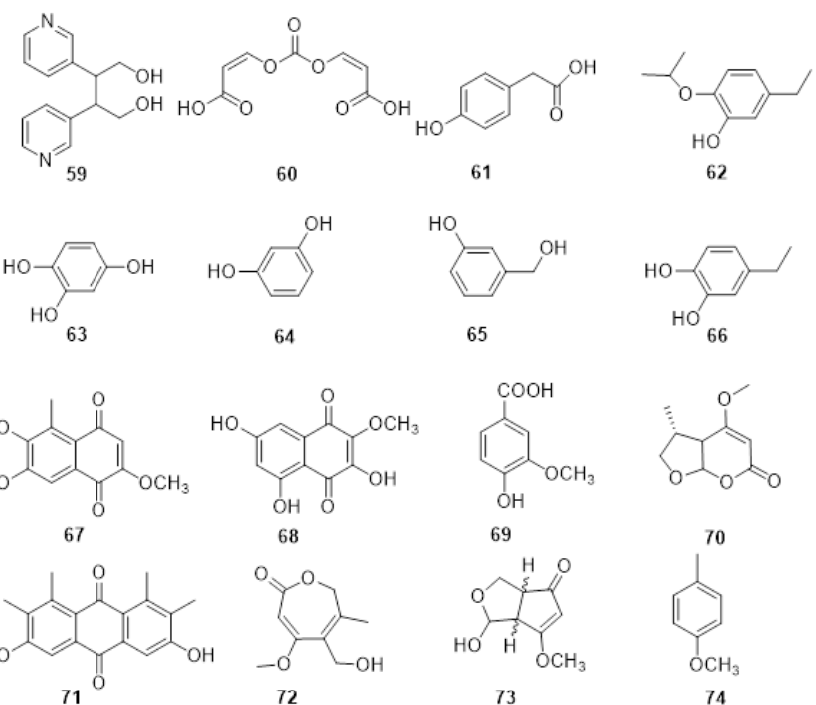
Figure 6. Structure of spencertoxin ( 59 ), spencer acid ( 60 ), 2-(4-hydroxyphenyl) acetic acid ( 61 ), 5-hydroxymethyl-2-isopropoxyphenol ( 62 ), benzene-1,2,4-triol ( 63 ), resorcinol ( 64 ), 3-(hydroxymethyl) phenol ( 65 ), protocatechuic alcohol ( 66 ), diploquinone A ( 67 ), diploquinone B ( 68 ), vanillic acid ( 69 ), luteopyroxin ( 70 ), neoanthraquinone ( 71 ), luteoxepinone ( 72 ), (±)-nigrosporione ( 73 ) and 4-cresol ( 74 ).